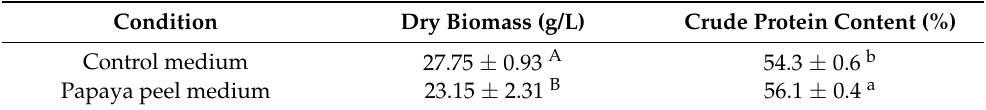
Table 3. Dry weight and the protein content of dry biomass produced in papaya peel medium and control medium under optimized conditions.